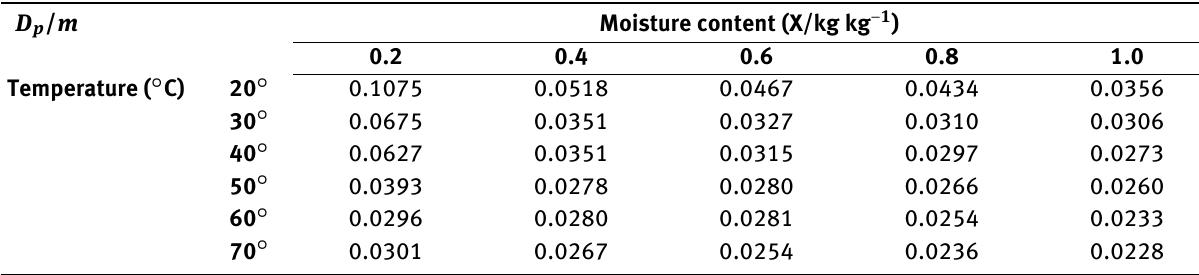
Table 2: The microwave penetration depth in paracetamol at temperatures between 20 and 70 ∘ C and in the moisture contents range of 0.2–1 kg kg −1 (2450 MHz).